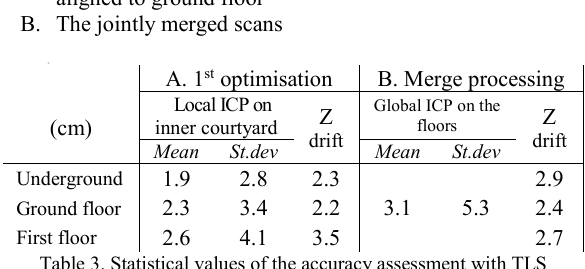
Table 3. Statistical values of the accuracy assessment with TLS reference and evaluation of Z drift error on ZEB 1.8